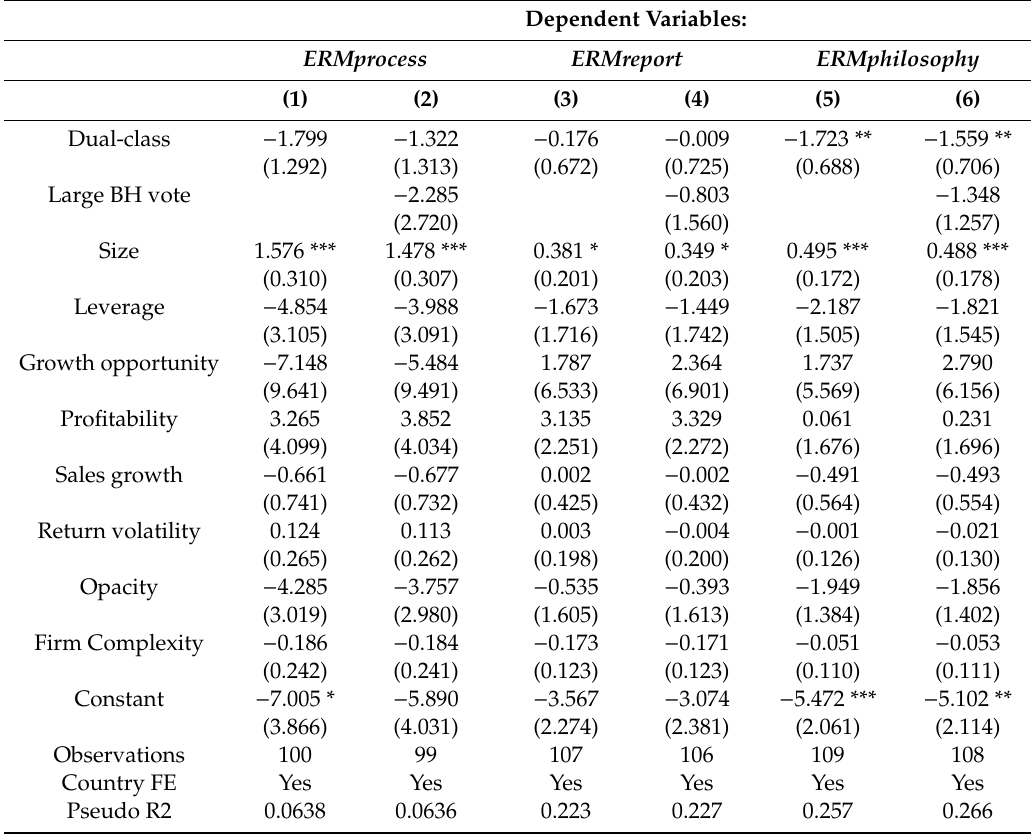
Table 5. Dual-class Share Mechanism and